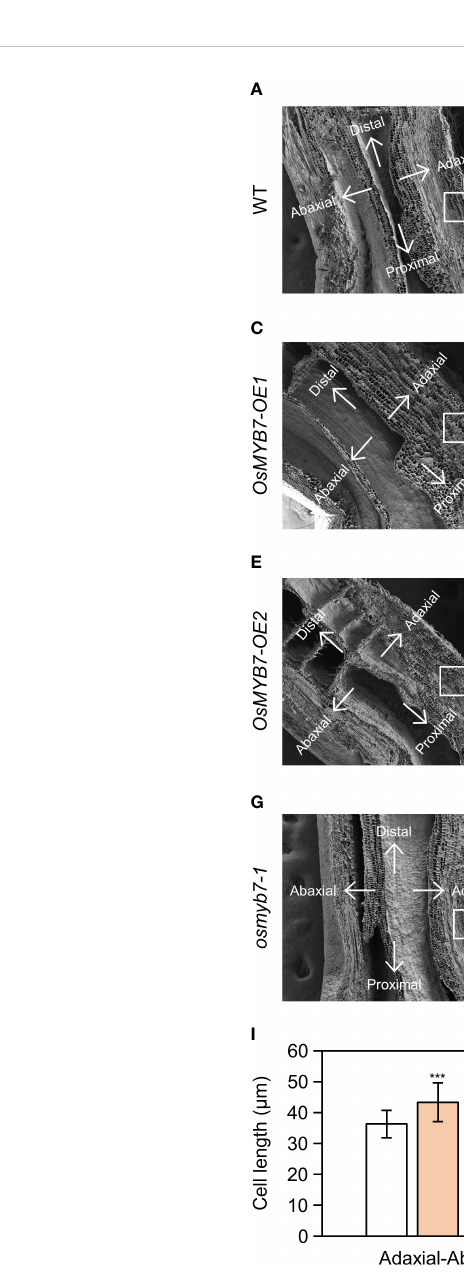
FIGURE 8 Scanning electron microscopy examination of the lamina joint. (A – H) Longitudinal sections of fl ag leaf lamina joints at the S5 developmental stage in WT (A) , OsMYB7-OE1 (C) , OsMYB7-OE2 (E) , and osmyb7-1 (G) plants grown under natural long-day conditions in a paddy fi eld. Close-up views of the adaxial region denoted by rectangles in (A , C , E, G) are shown in (B , D , F , H) , respectively. Scale: 100 m m. (I) Adaxial cell length in (B , D , F , H) . Length of the adaxial cells was measured along the adaxial-abaxial axis and proximal-distal axis. Data are presented as means ± SD from 30 cells. Asterisks indicate signi fi cant differences compared to WT, as determined by two-tailed Student ’ s t -test (* P < 0.05 and *** P < 0.001). Similar results were obtained from at least three independent